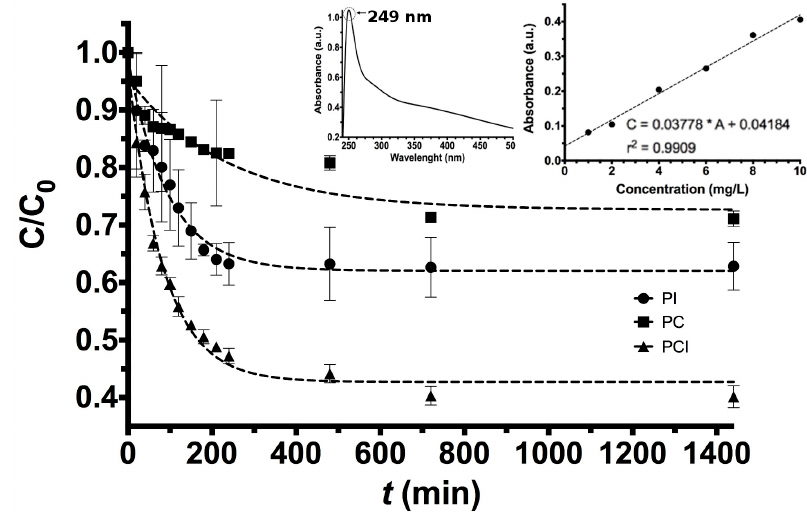
Figure 4. Removal conditions of Pb(II) ions by 192 mg of PC, PI or PCI material using λ = 249 nm as maximum absorbance at pH = 7.8 and 25 °C. C = ion Lead concentration; C 0 = Pb 2+ initial concentration, 10 mg/L; C/C 0 = Pb 2+ fractional removal; t = contact time between material and lead solution.